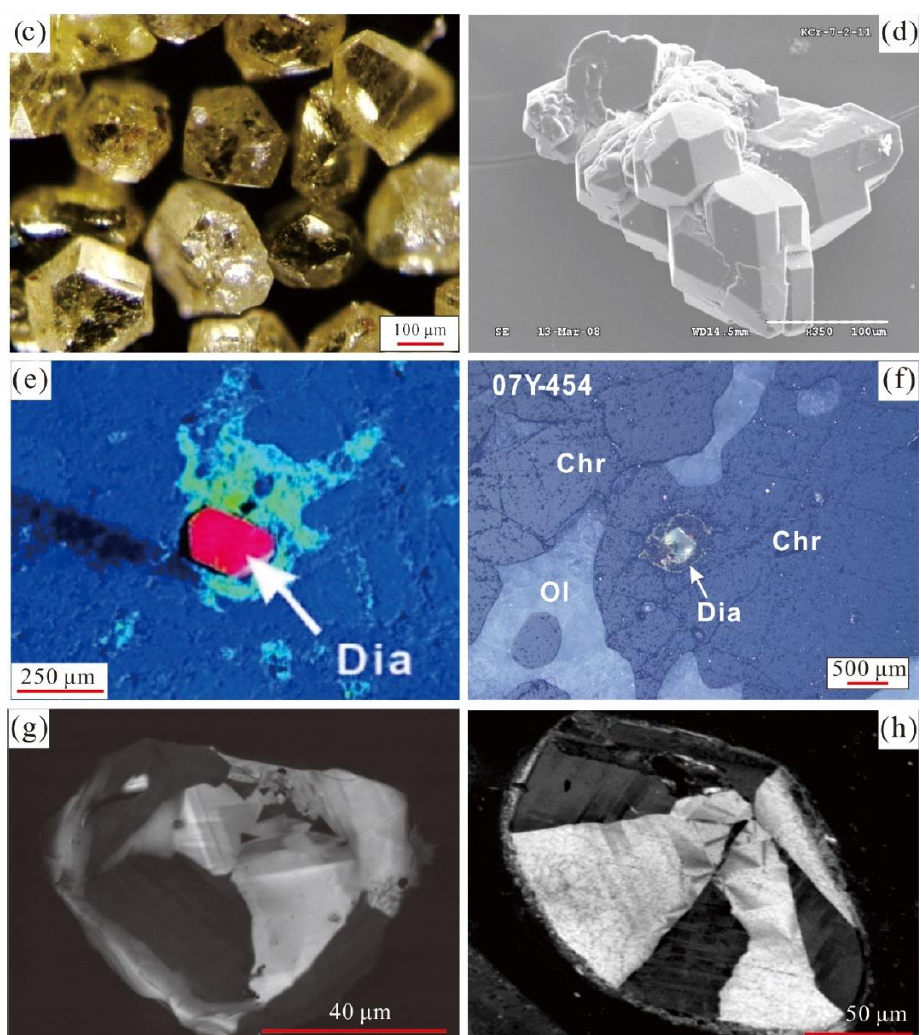
Figure 4. Photomicrographs of ophiolite-hosted diamonds from chromitite and peridotite. ( a ) Diamonds from the Ray-Iz chromitite, Russia [17]; ( b ) diamonds from the Pozanti-Karsanti (Aladag) chromitite, Turkey [32]; ( c ) diamonds from the Ray-Iz chromitite, Russia [24]; ( d ) backscattered secondary electron image showing polycrystal striations on the diamond surface [20]; ( e , f ) chromite hosted in an in situ diamond [24]; ( f ) in situ diamonds hosted by chromitite from the Luobusa and Ray-Iz, respectively [24]; ( g ) cathodoluminescence (CL) image of a Kalamyo harzburgite-hosted diamond [58]; ( h ) CL image of a Luobusa harzburgite-hosted